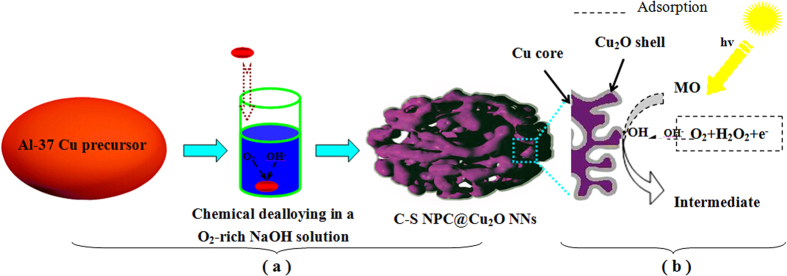
The schematic illustration showing (a) the preparation process of the monolithic C-S NPC@Cu2O NNs and (b) the photodegradation mechanism of MO.